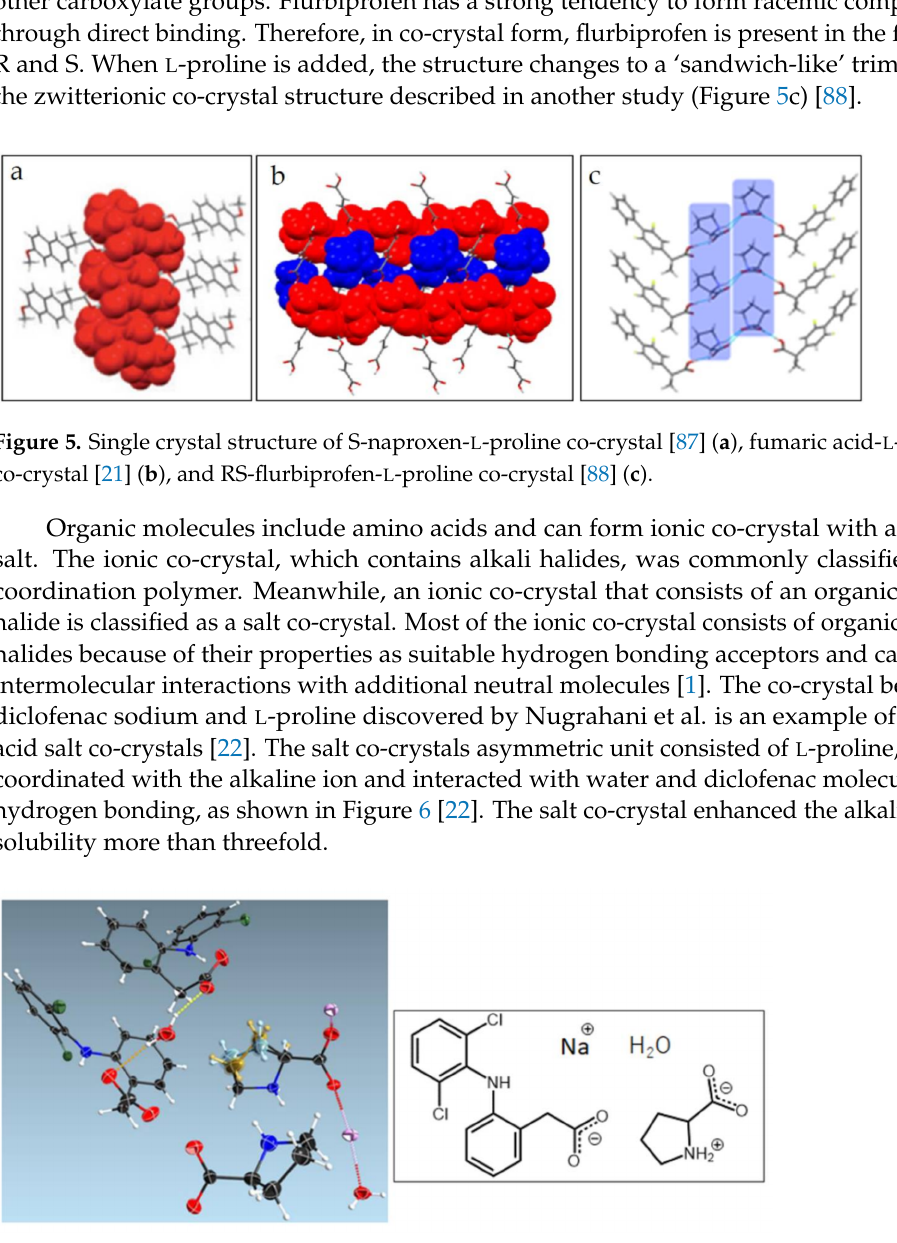
Figure 6. Crystal structure of sodium-diclofenac- L -proline tetrahydrate salt co-crystal with Na + coordinated with two L -proline (LP) and four water molecules